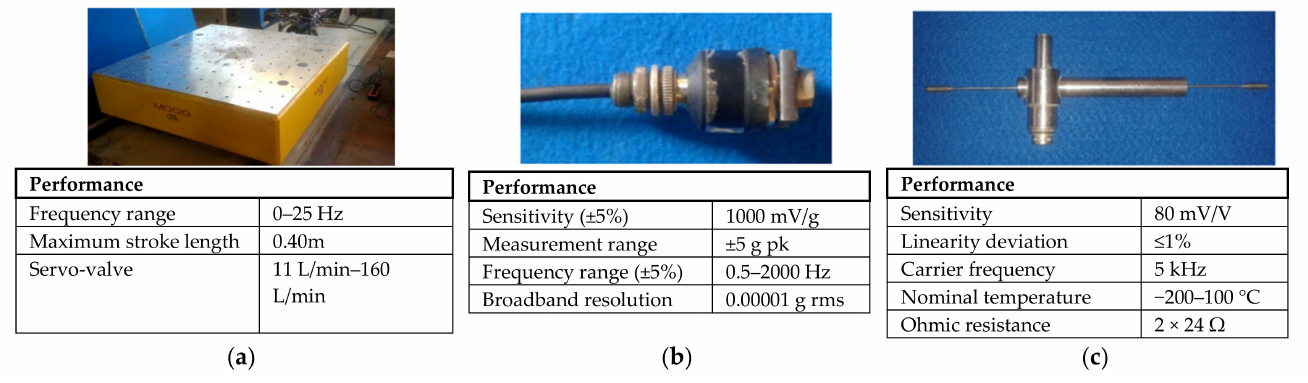
n. 8 PCB piezotronic accelerometers (Figure 6b) and n. 2 LVDTs—Linear Variable Displace- ment Transducers (Figure 6c). The instruments were positioned as indicated in Figure 7,